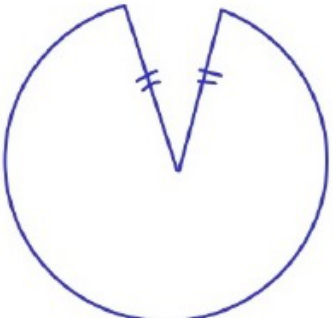
Figure 1. A flat sheet with a wedge cut out of it and the wedge’s sides identified. Here it is drawn circular, but this does not